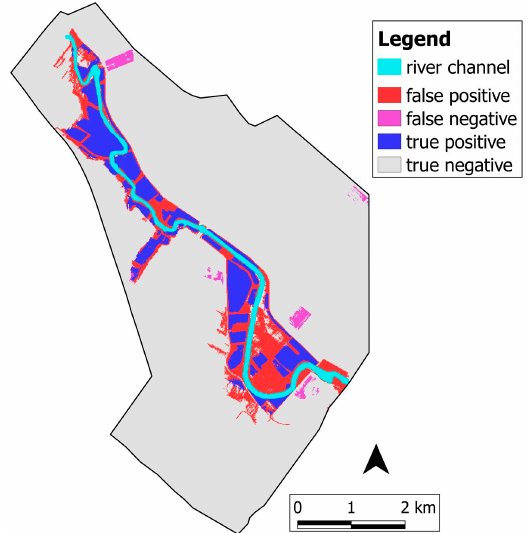
Figure 3. Example of contingency map obtained by pixel-to-pixel comparison of the hydraulic simulation using variable spatio-temporal Manning coefficients, as in [45], and the Synthetic Aperture Radar (SAR)-derived flood extent map at the same time step, i.e., 4:47 a.m. of 3 November 2010.